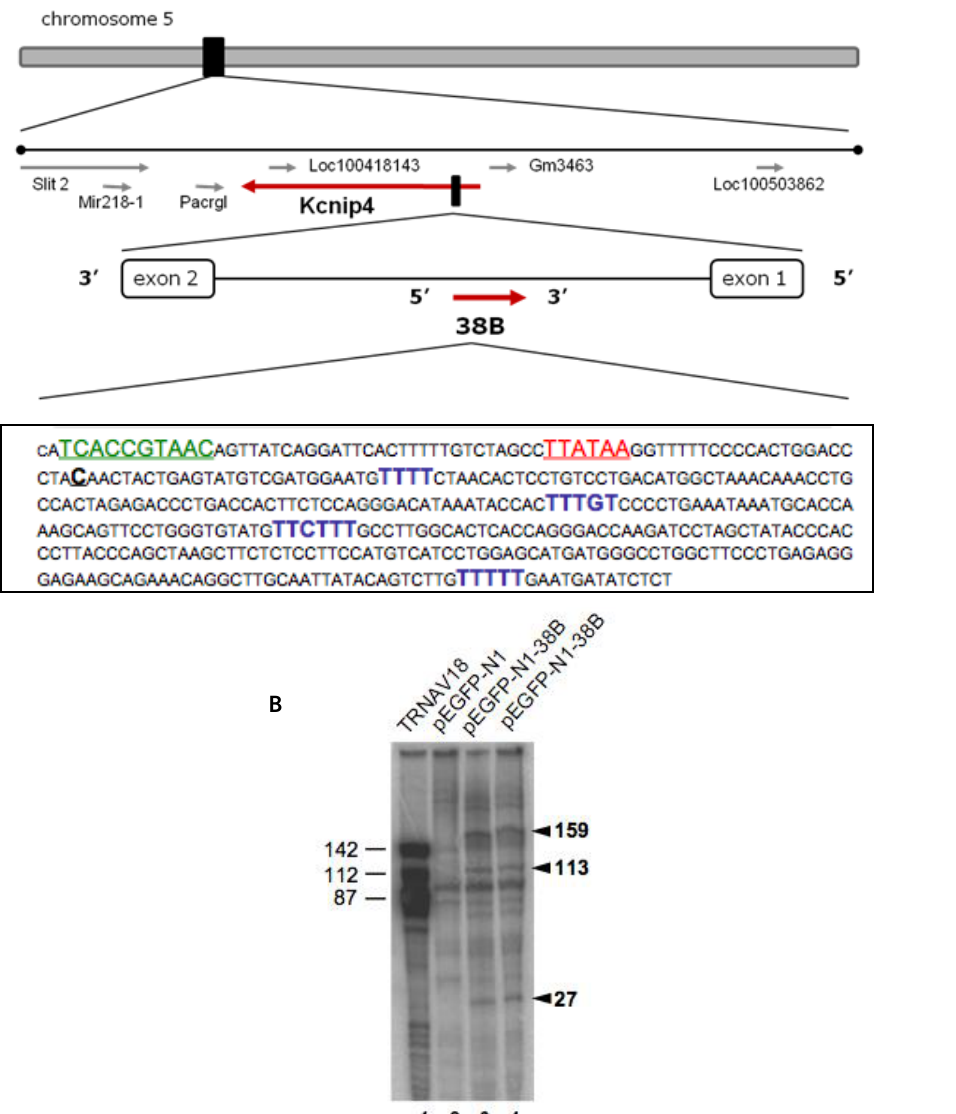
Figure 2. ( A ) Subchromosomal localization of the mouse 38B transcription unit. The functional consensus sequences are indicated in bold. Green, Proximal Sequence Element. Red, TATA box. Blue, Transcription Termination signals. The putative transcription 38B start site, located 29 bp downstream of the start of the TATA element, is also in bold and underlined; ( B ) In vitro transcription products of 38B. A HeLa cell nuclear extract was programmed with either pEGFP-N1 vector (lane 2), the same vector carrying the 38B transcription unit (lanes 3,4) or the human tRNA gene TRNAV18 carried by pGEM-T-Easy vector (lane 1). The length of 38B-specific transcripts (indicated by arrowheads on the right) was estimated on the basis of the migration positions of the three main TRNAV18 transcripts, generated by termination at different termination signals